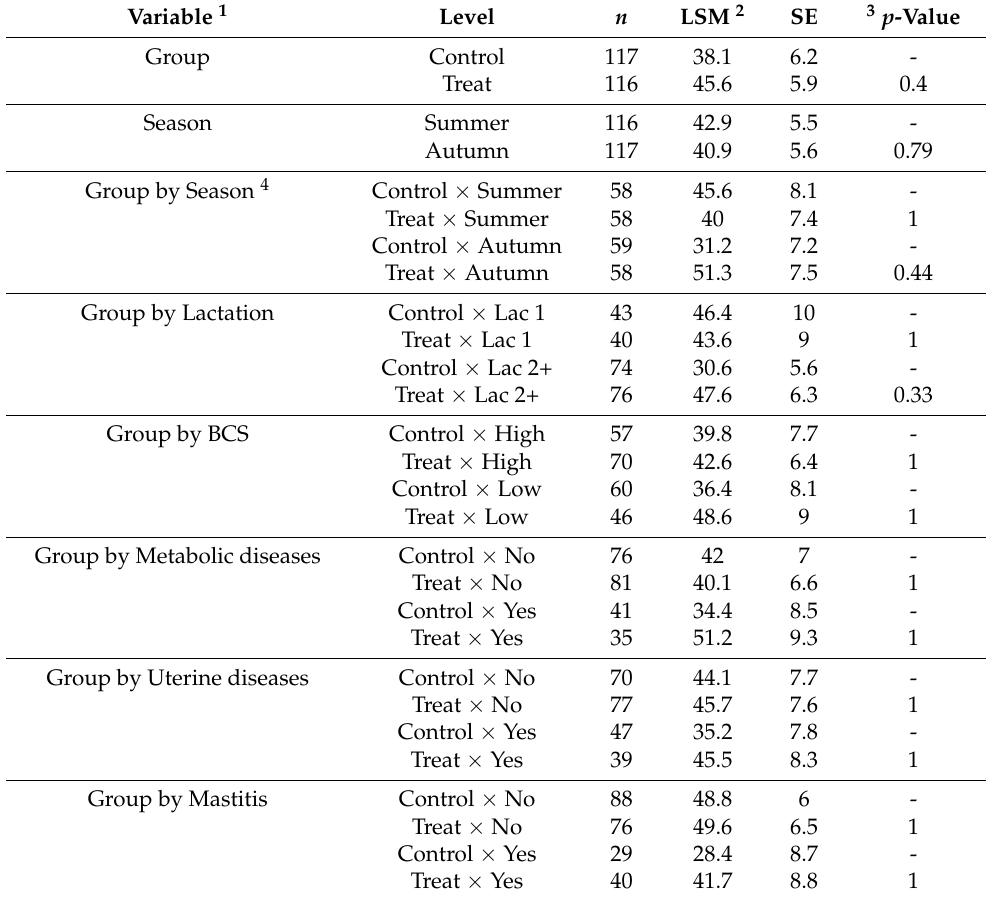
Table 3. Generalized mixed model (GLIMMIX) used to estimate the effect of GnRH administration at onset of estrus on probability of conception over the entire experimental period (summer and autumn). Group and season, and interactions with group are presented.